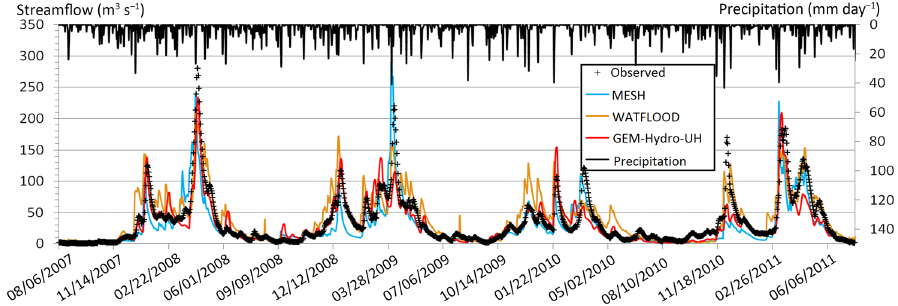
Figure 6. Intercomparison for the Moira River (calibration period, CaPA precipitation).